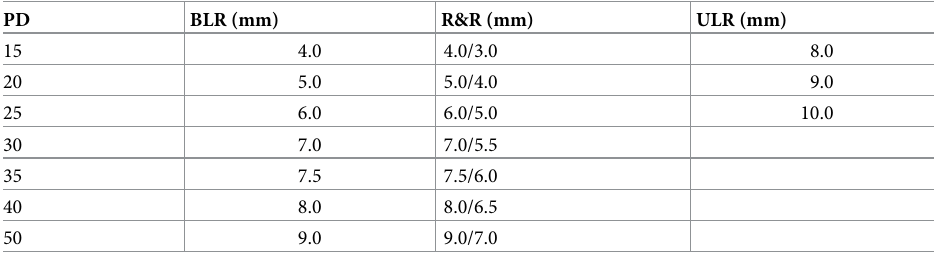
9.0/7.0 PD, prism diopters; BLR, bilateral lateral muscle recession; R&R, unilateral lateral rectus recess-medical rectus resection; ULR = unilateral lateral rectus